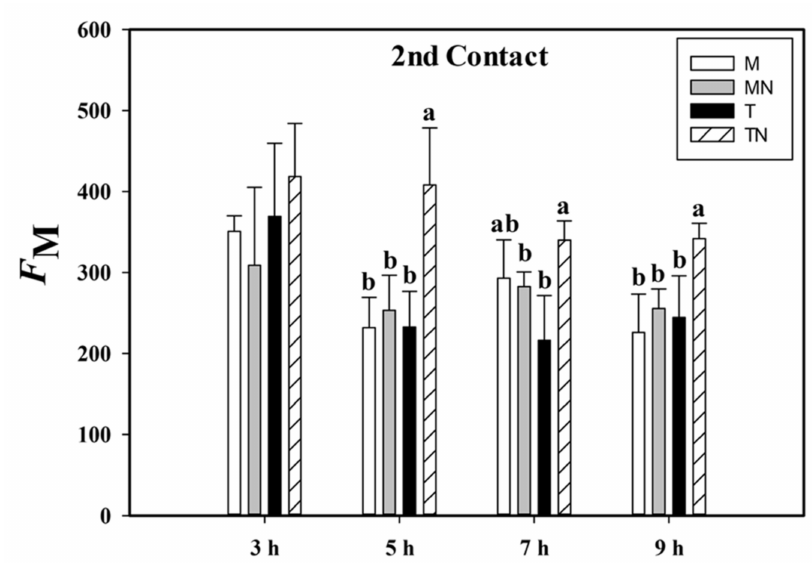
Figure 3. Maximum fluorescence ( F M ) of the second contact with the MeJa (treated (T)), mock (M), treated neighbor (TN), and mock neighbor (MN) groups. MeJa was applied to the first fully expanded leaf of the plants in the T group at 6:00 a.m., 0 h after application (HAA), and evaluations were made at 3, 5, 7, and 9 HAA. The results are from a one-way ANOVA repeated measures, followed by Tukey’s test with a significance level of 5% ( p < 0.05). The data refer to means ( n = 4), error lines indicate standard deviation. Lowercase letters indicate differences between the groups in the respective evaluations ( p < 0.001).